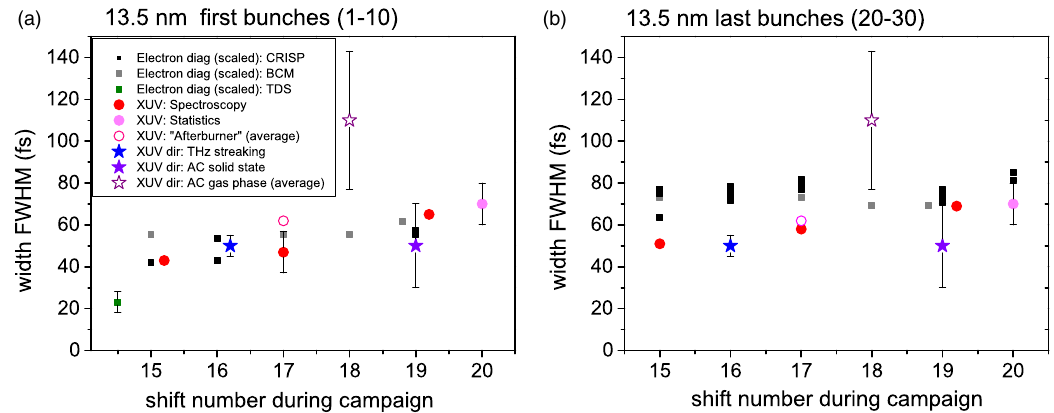
FIG. 12. XUV and electron bunch pulse duration (FWHM) measured during the 13.5 nm run. (a) shows the pulse durations for the first bunches (1 – 10) in the bunch train; (b) shows the pulse durations for the last bunches (20 – 30). The electron bunch duration is scaled for best fit with the average XUV pulse by a factor of 0.4. The electron pulse measurements are indicated by a rectangular symbol, indirect photon pulse duration measurements by circles, and direct XUV measurements by stars. Furthermore, the pulse-resolved methods are plotted with solid symbols, while the averaging techniques are shown as open symbols. The horizontal axis indicates the shift number during the campaign. The first 15 shifts were used for setting up the FEL and the various experiments. One shift corresponds to 8